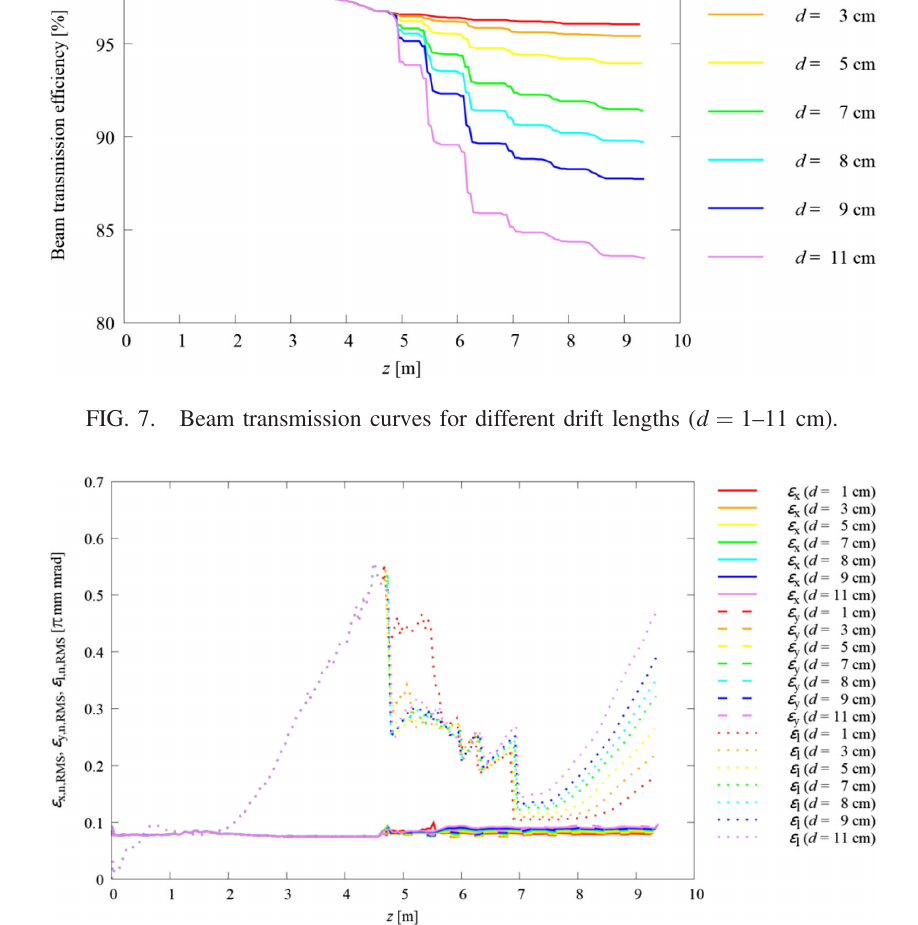
FIG. 8. Emittance evolution curves for different drift lengths ( d ¼ 1 – 11 cm).